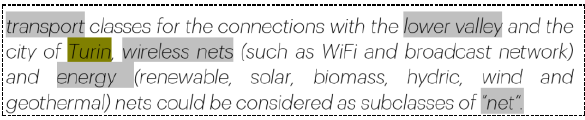
Figure 15. Concepts, relations and properties of networks.